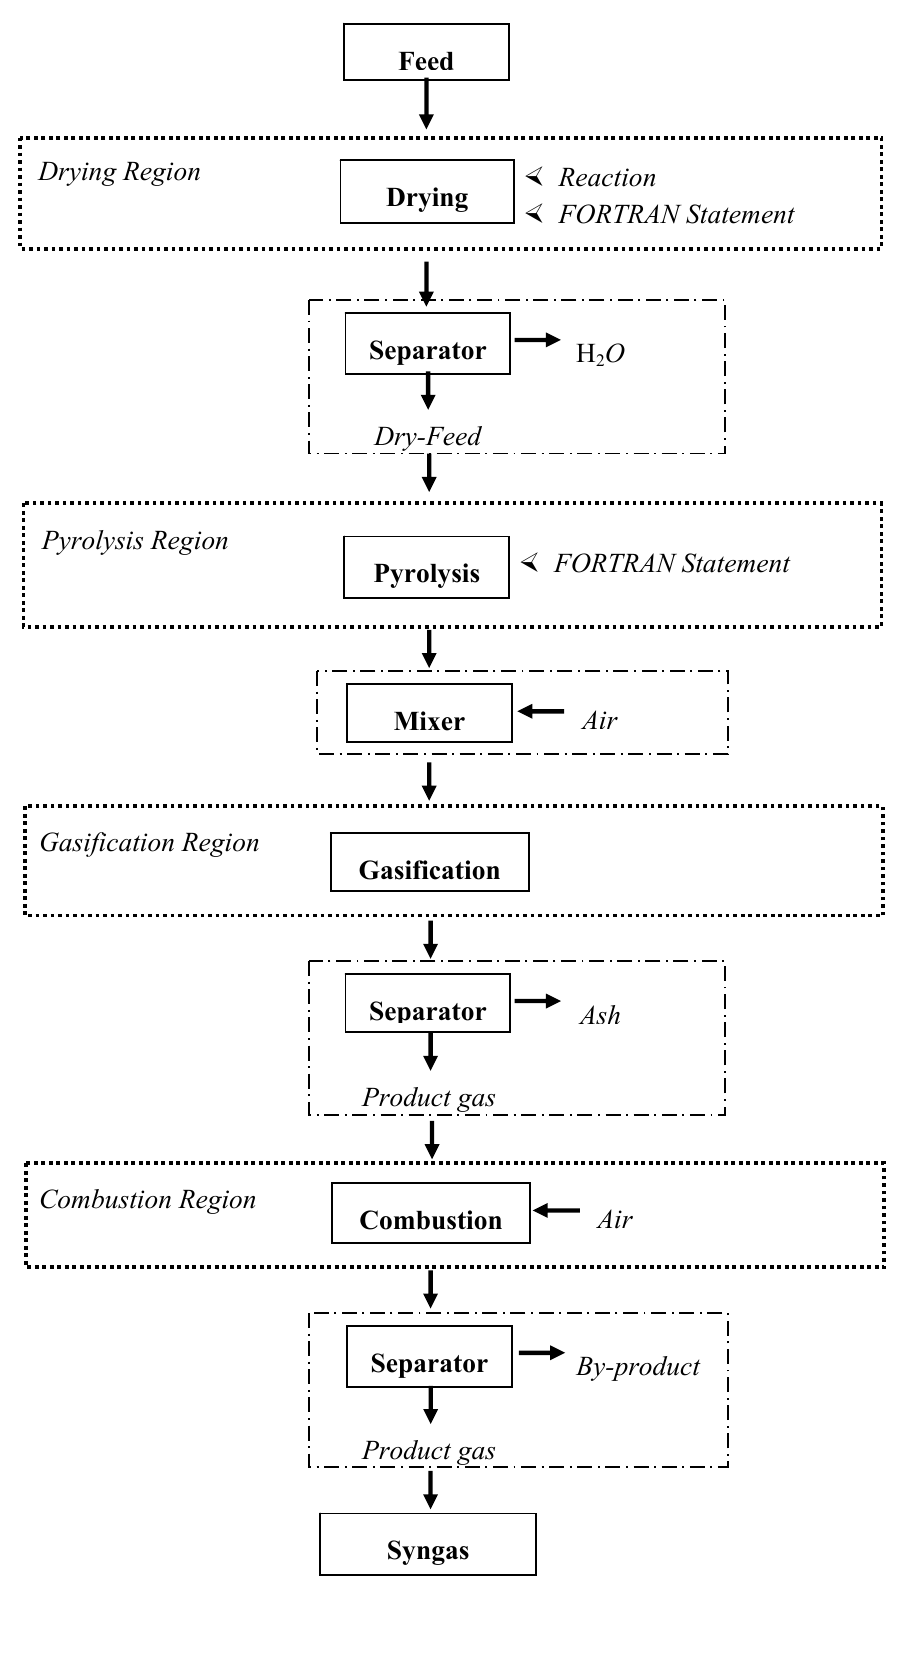
Figure 1. Process flowsheet of gasification in fixed bed